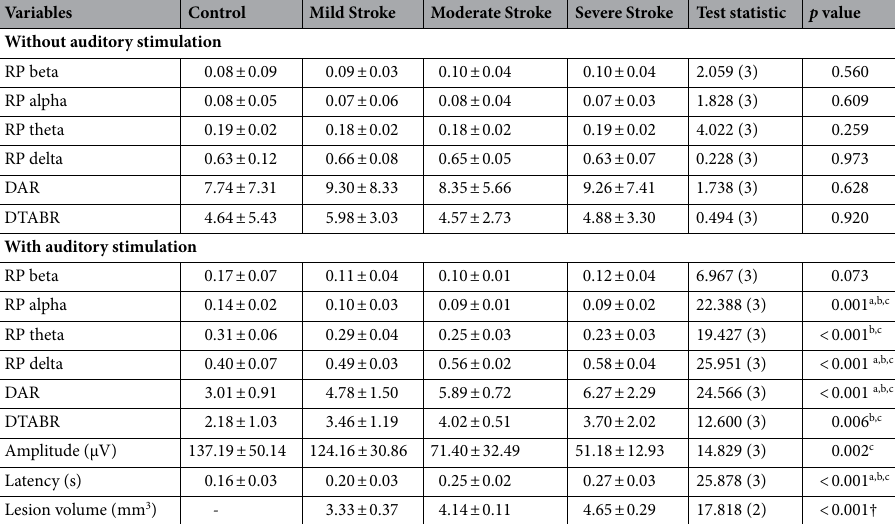
Figure S2 demonstrated the four averaged AEP waveforms on a single graph, which highlights the intergroup differences. These findings indicate that the relative powers in the alpha, theta, and delta, DAR, and DTABR as well as the amplitude and latency of the AEPs under auditory stimuli are the EEG parameters that reflect post-stroke brain injury.